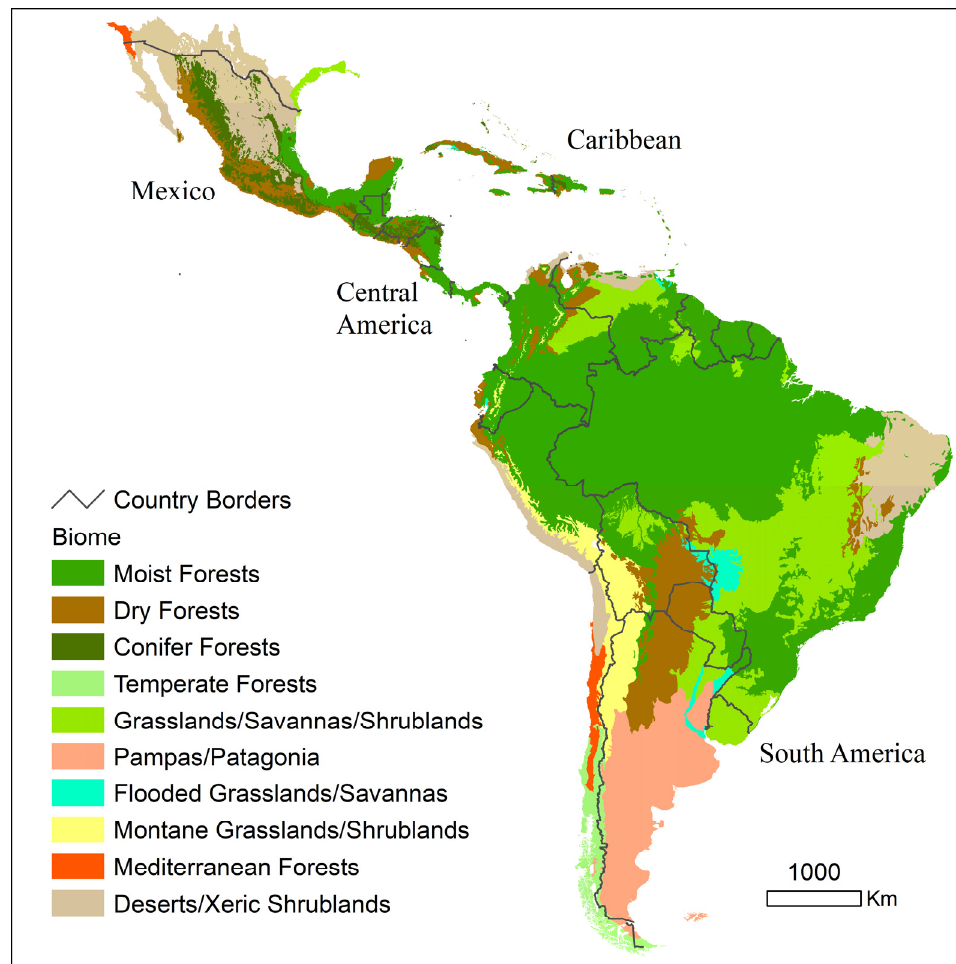
Figure 1. Terrestrial biomes of Latin America and the Caribbean with the short names used in this study (see Table 1).